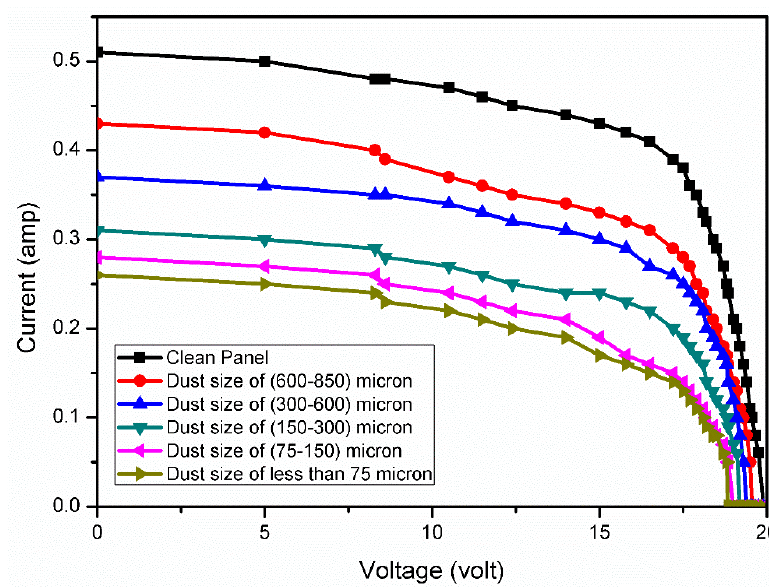
Figure 12. I-V curves of the solar PV panel for different dust size .